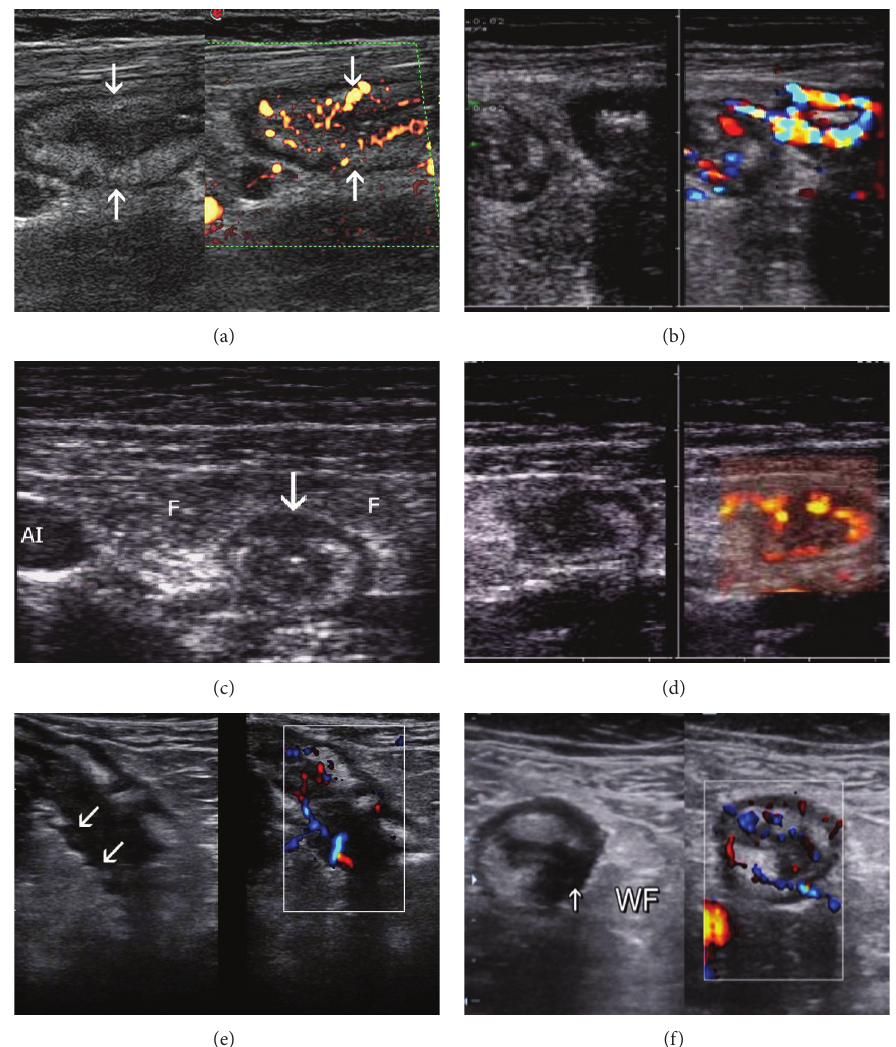
Figure 2: TUS in Crohn’s disease. (a) Transversal view of thickened terminal ileum with preserved stratification and intramural hyper- vascularisation— High resolution probe. (b) Transversal section of two ileal bowel loops—proximal (left) with segmentally impaired stratification, distal with complete absence of stratification with hypoechogenic wall. The right half of picture shows intramural hyper- vascularisationespeciallyinproximalloop,indicatingactiveinflammation— Highresolutionprobe .(c)Transversalviewofterminalileumwith hypoechogenic bridge through echogenic submucosa between lumen and outer surface of the wall indicating transmural ulcer (arrow) and thickened inflamed “wrapping” fat (F)— High resolution probe . (d) Blind fistula wrapped by inflamed fat. Increased intramural vascularisation incolor-PowerDoppler(CFD)— Highresolutionprobe. (e)Segmentalabsenceofechogenicsubmucosaindicateslongitudinalulcerofterminal ileum (arrows) in longitudinal and (f) transversal view in a Crohn’s ileitis (WF-inflamed fat)-FDsign— High resolution probe.